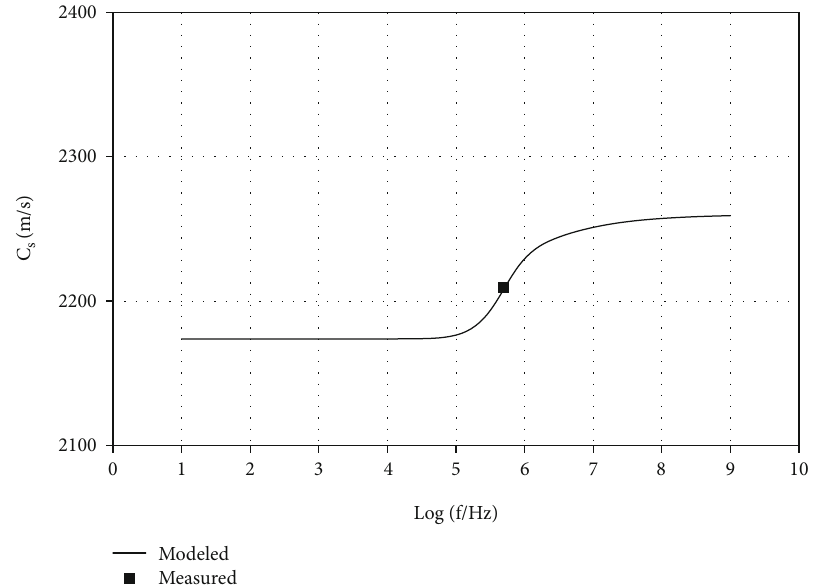
Figure 1: Predicted S-wave velocity ( cs ) against the ultrasonic measurement (black square) for water-saturated D ’ Euville limestone under di ff erential pressure of 3MPa, in which f is the frequency.